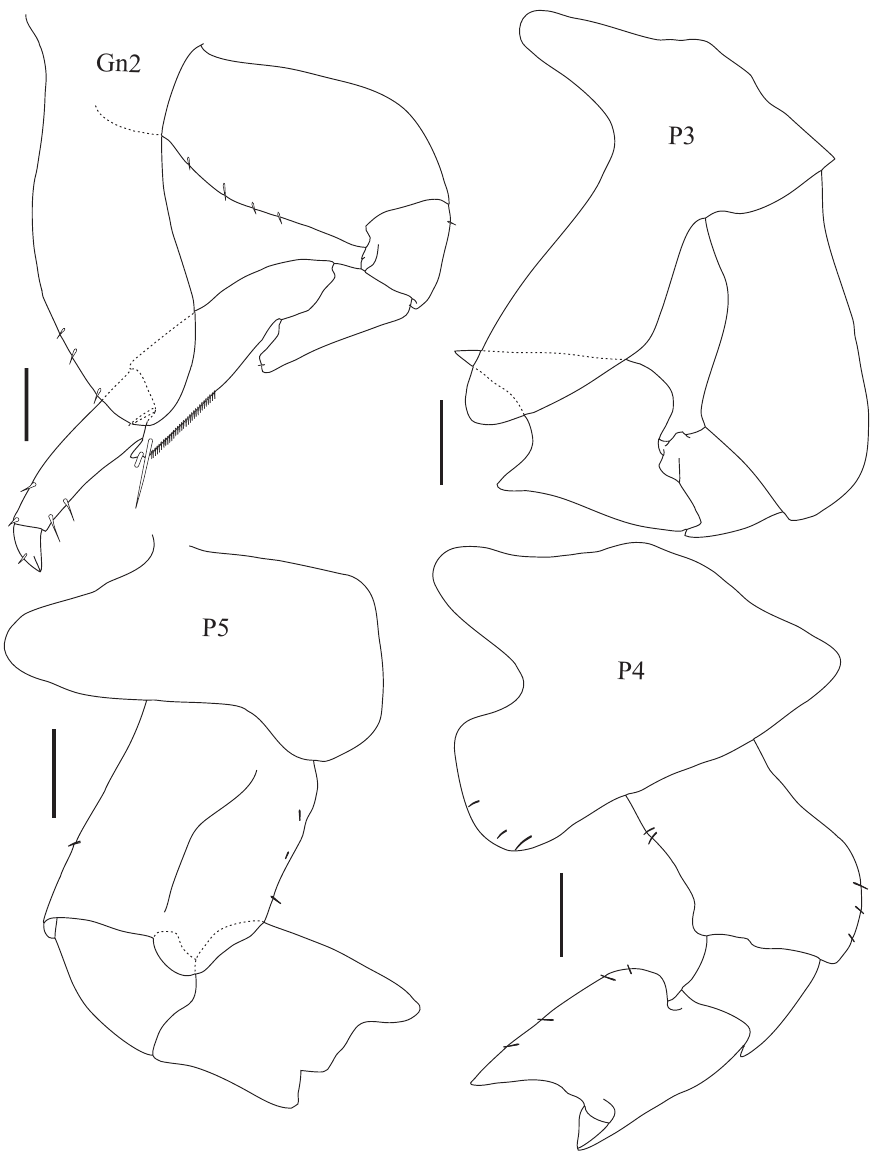
Fig . 4. – Curidia wakabarae n. sp., reVizee Benthos sCore/northeast, holotype female, 2.42 mm, Fernando de noronha Chain, Pequeno island, station #88a (3.83°s; 34.71ºW), MnrJ 20868. scale bar = 0.1 mm. Gn2: gnathopod 2; P: than long, slightly excavate ventrally, anterior epimeron 3 with pointed tooth. uropod 1 extending margin produced; basis broad with inconspicuous beyond uropods 3, peduncle as long as ramus with ridge on lateral face, posteroventral angle rounded, one single apicolateral spine and 2 medial marginal merus angle posteroventral produced. Pereopod 6, spines, ramus lanceolate, subequal in length, outer coxa wider than broad with 2 excavation ventrally; ramus with 4 lateral and 3 medial spines, inner ra- basis similar to pereopod 5; merus and carpus pos- mus with 3 lateral and 3 medial spines. uropod 2 teroventral angle produced; propodus 3.5 x as long missing. uropod 3 biramous, peduncle with single as wide; dactylus more than 1/2 of propodus length. apicolateral spine; outer ramus about 0.5 x the inner Pereopod 7, coxa with a small excavation ventrally; ramus, with single medial spine; inner ramus with basis to dactylus similar to pereonite 6. single lateral and 2 medial spines. telson entire with Pleonite 2 with obtuse mid-dorsal hump. Pleonite single pair of lateral setae, 1.7 x as long as wide, api- 3 with a narrow apically rounded mid-dorsal carina. cally rounded.